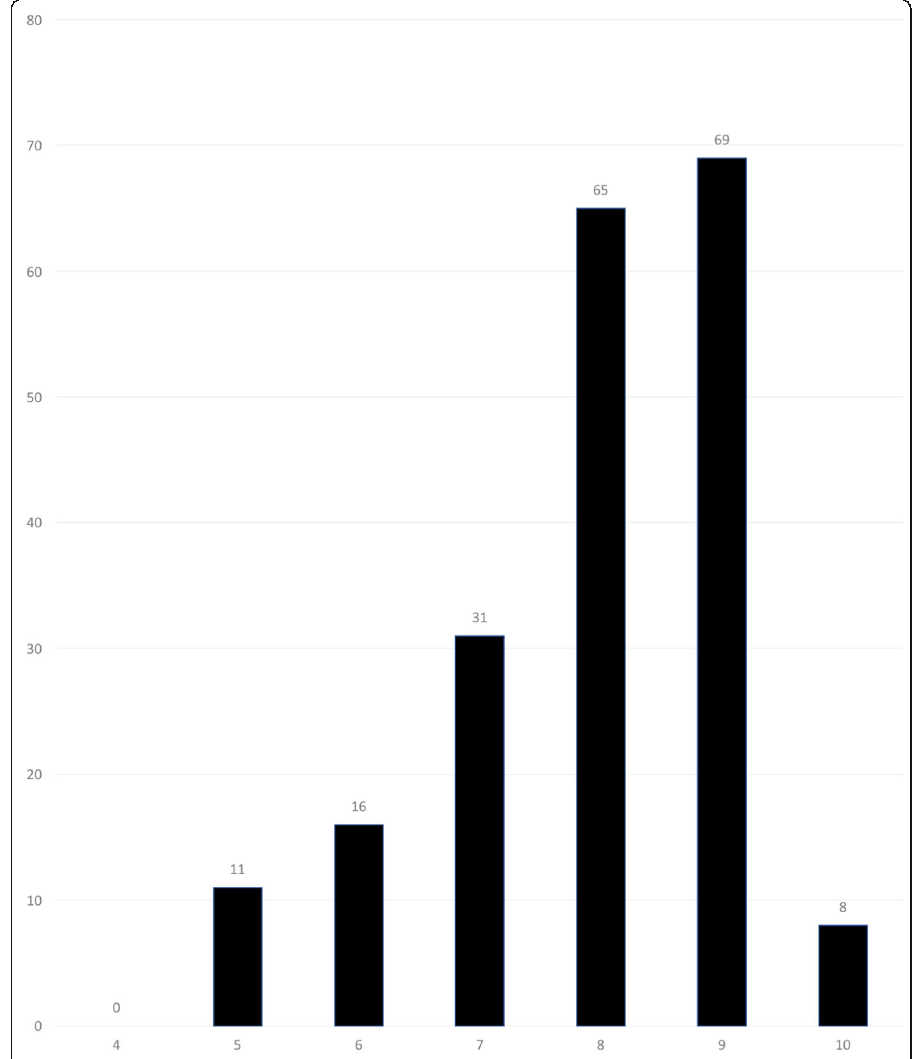
Fig. 2 Change in diagnostic confidence with xSPECT. Detailed legend: X-axis: scores of diagnostic confidence 0 – 10. Score 0 – 4 indicate a reduced diagnostic confidence, 5=no change, and 6 – 10 indicate increasing confidence. Y-axis: Number of patients in each category